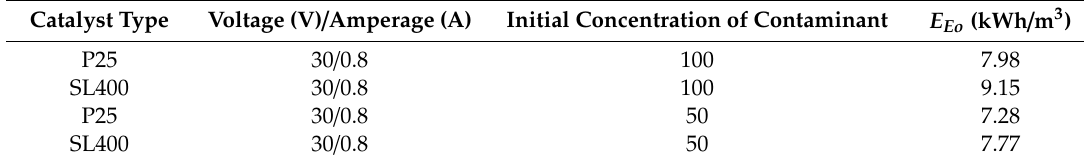
Table 5. Electrical oxidation efficiency for the catalysts used.